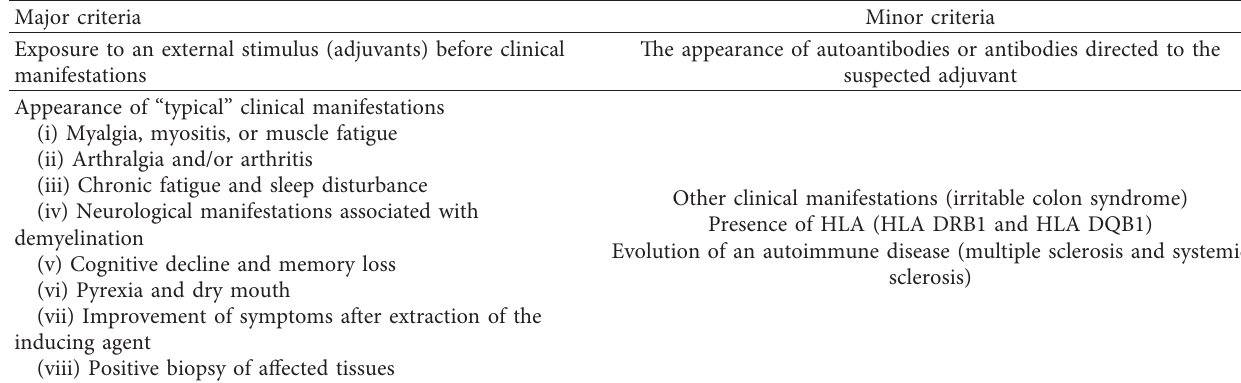
Table 2: Diagnostic criteria for ASIA